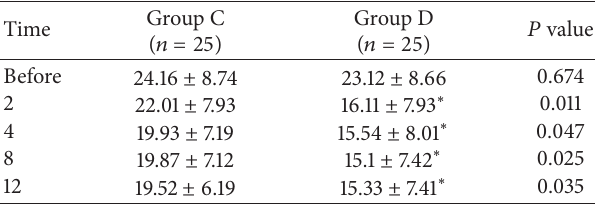
Table 4: Oswestry disability index